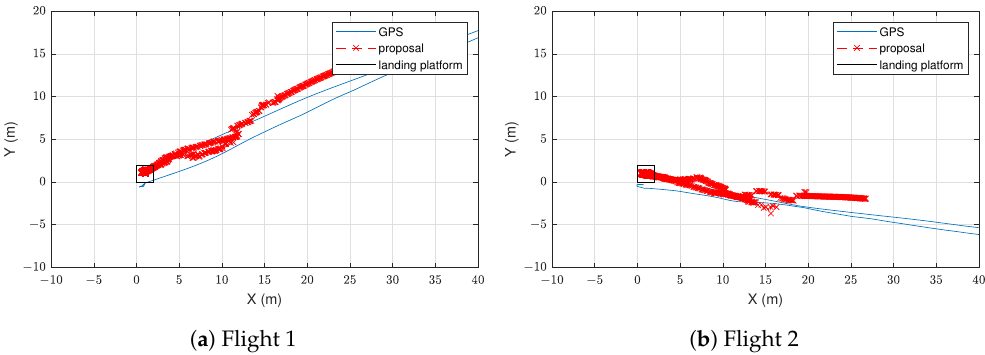
Figure 12. Estimated trajectory in the outdoor environment by the combination of tags. Estimates of the proposed landing assistance system (LAS) are given in red colour. Blue line represents the trajectory given by the global navigation satellite system (GNSS) of the